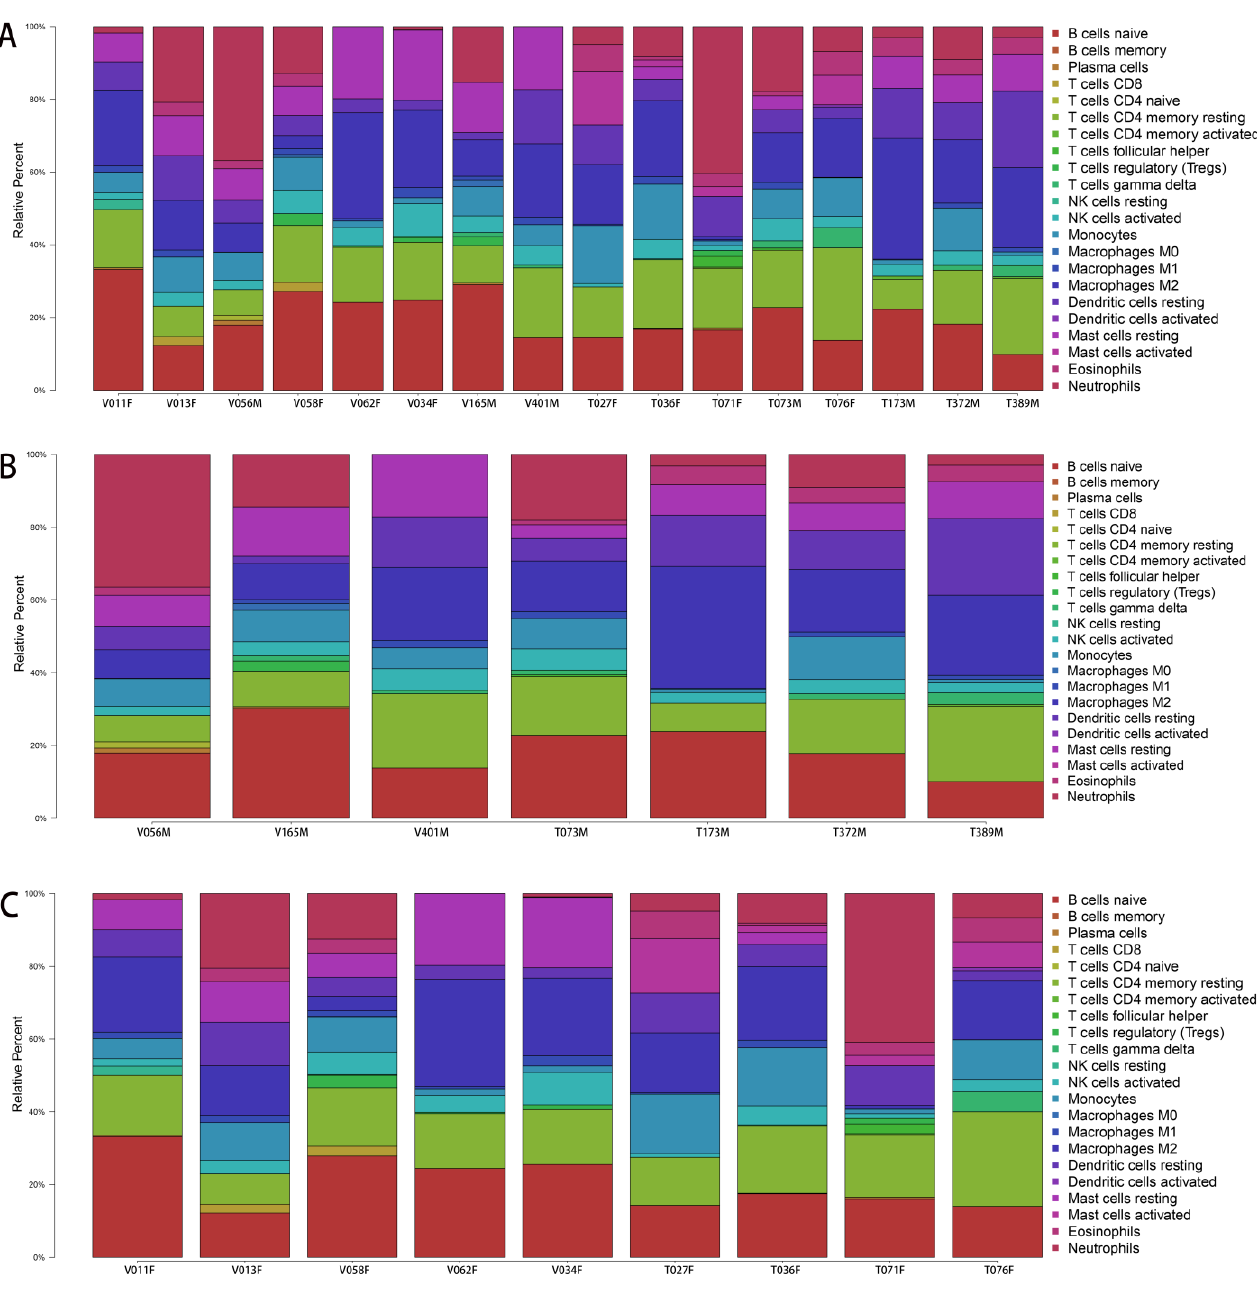
Figure 8. Bar charts showing the proportions of infiltrated immune cells. ( A ) Bar charts of immune cell infiltration in AVF patients. ( B ) Bar charts of immune cell infiltration in male AVF patients. ( C ) Bar charts of immune cell infiltration in female AVF patients.